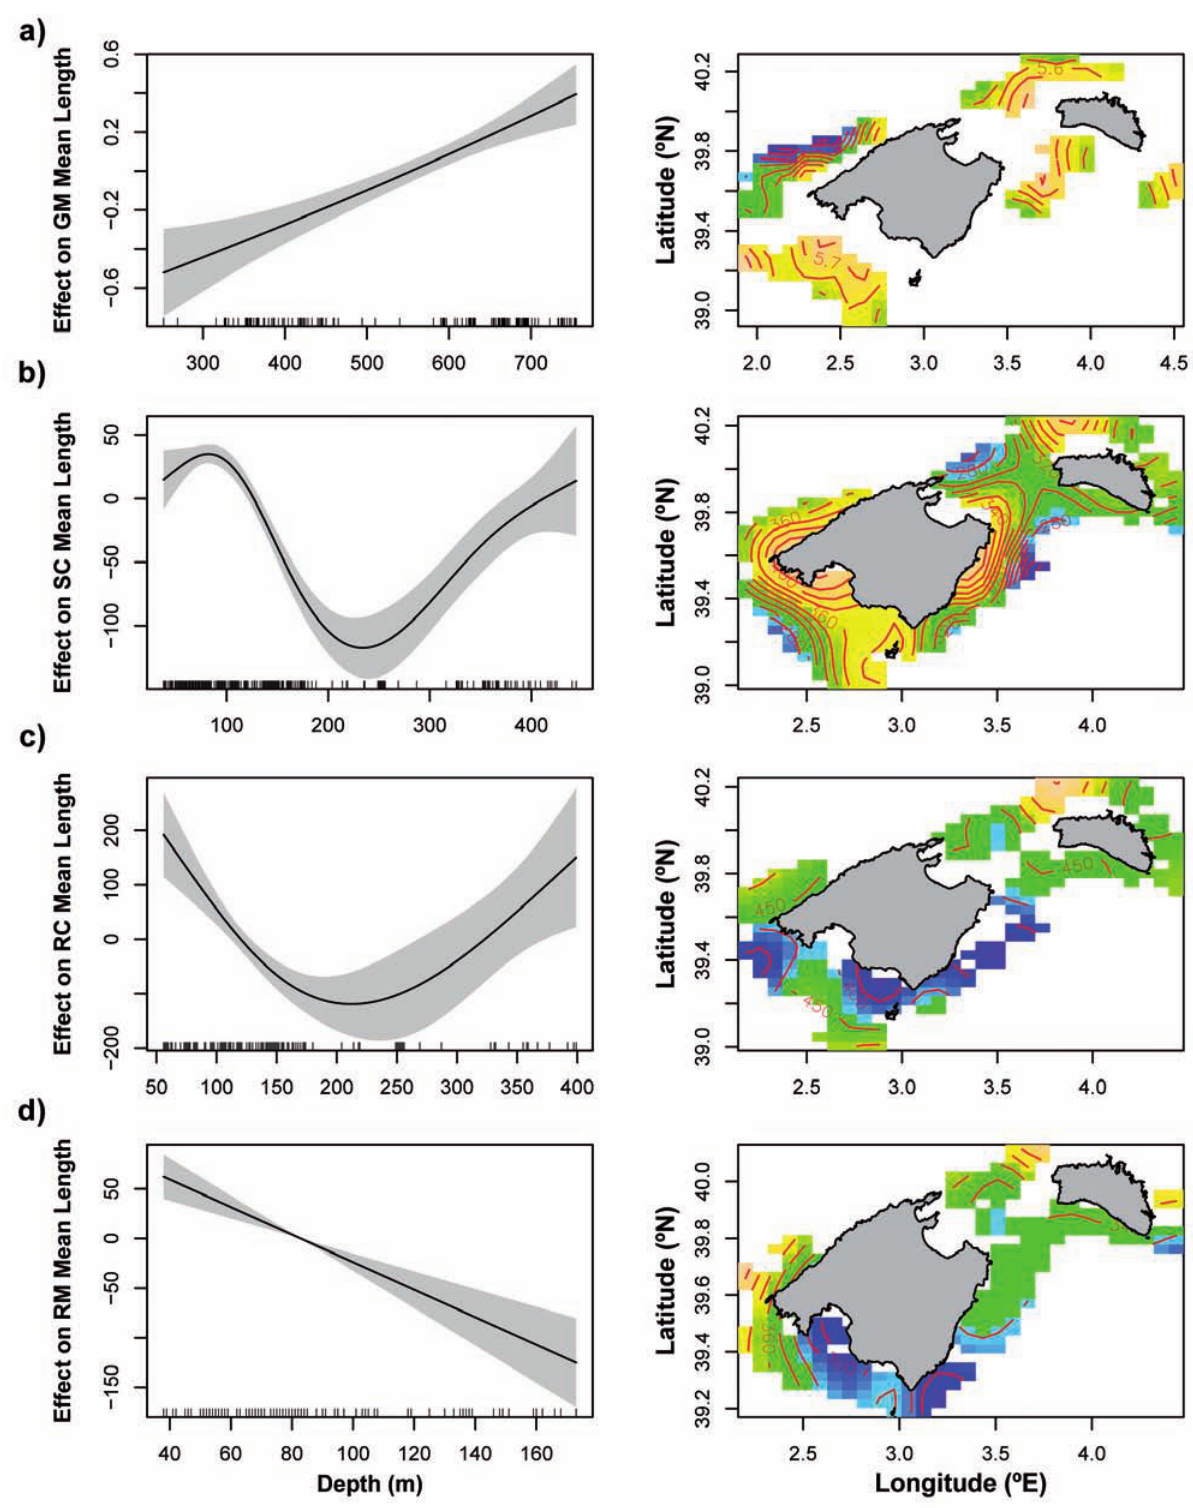
Fig . 5. – Partial effects of bottom depth and geographic position on G. melastomus (a), S. canicula (b) , R. clavata (c) and R. miraletus (d) mean length, estimated from the spatially explicit variable coefficient generalized additive model. For the position plot, orange indicates high predicted values, green medium values and blue indicates low values. Shaded areas on the depth plot are 95% confidence intervals, and tick marks on the x -axes of the depth plots indicate sampling intensity. Note that the x -axes for the plots representing the bathymetric distribution are different in order to take into account the distribution ranges of the